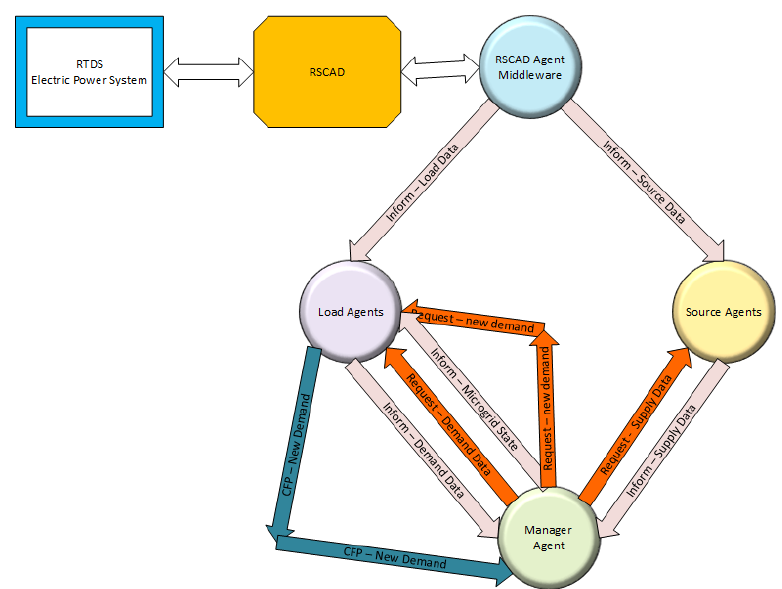
Figure 5. Flowchart of MAS